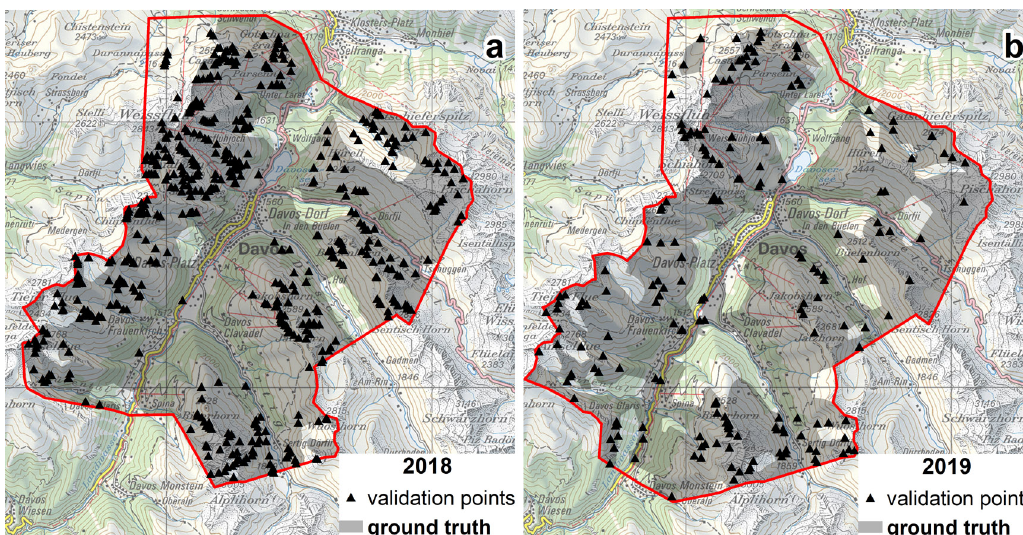
Figure 5. Coverage of the study area with ground truth for (a) 2018 and (b) 2019 avalanche periods. The black triangles represent validation points. Mapped avalanches at validation points located in the gaps of the ground truth could not be evaluated (map source: Federal Office of Topography).